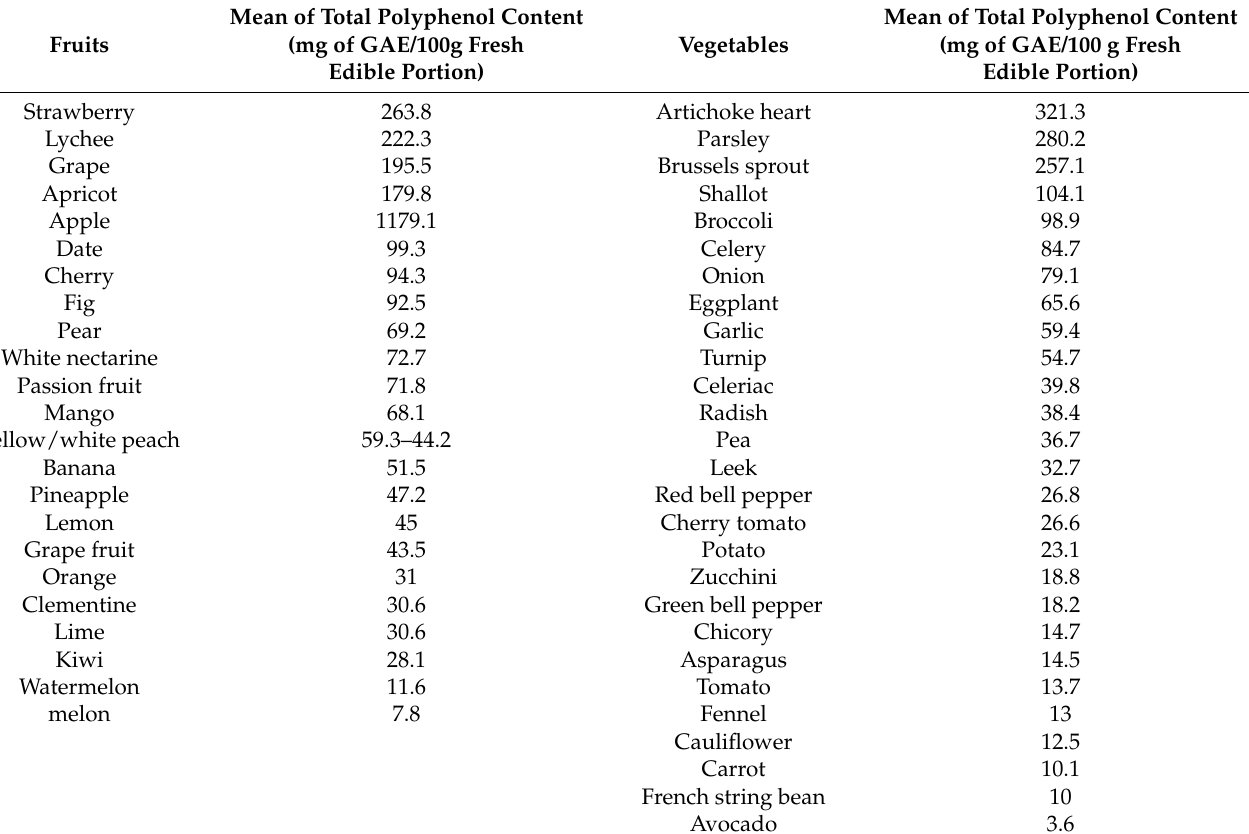
Table 1. Total polyphenols content of main edible plants from Mediterranean diet. Adapted from Debbabi et al.